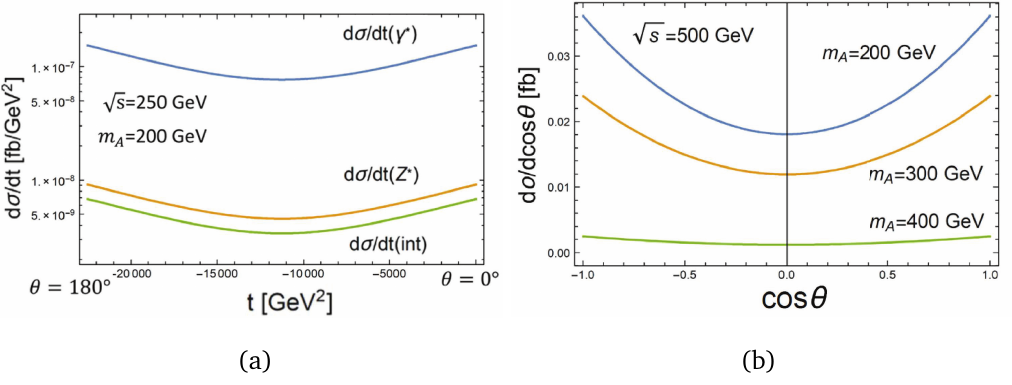
Figure 3: Differential cross section for A 0 production in e + e − collisions:(a) Three components of cross section and (b) A 0 mass dependence of differential cross